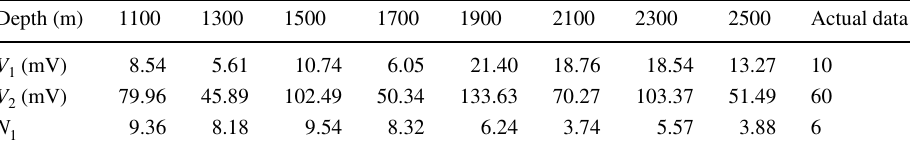
Table 6 Outburst risk index at different depths